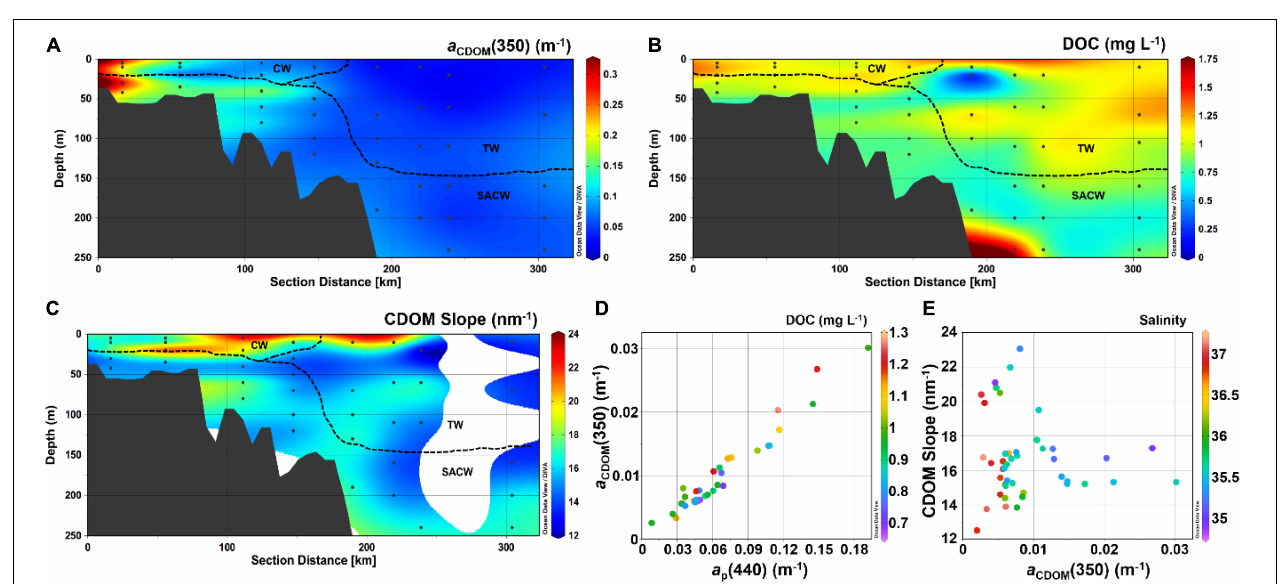
FIGURE 4 | Scatter plots of (A) Salinity vs. a CDOM (350) color-coded as Chl-a, (B) Salinity against Chl-a with DOC as colorbar, (C) Salinity against DOC and Chl-a as colorbar, (D) Chl-a vs. a p (440), (E) Chl-a vs. a CDOM (350) and (F) Chl-a against DOC. All plots except (D) were produced with Ocean Data View (Schlitzer, 2016).